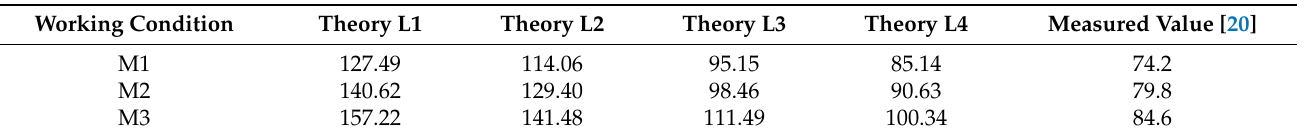
Table 3. Comparison between theoretical value and the measured value of the diffusion radius under different parameters (unit: mm).